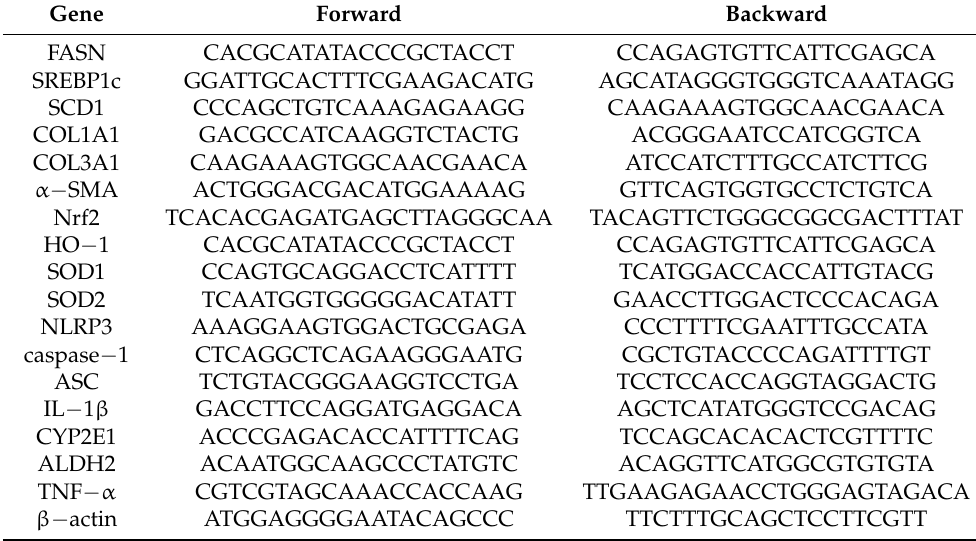
Table 1. Sequences of qRT − PCR